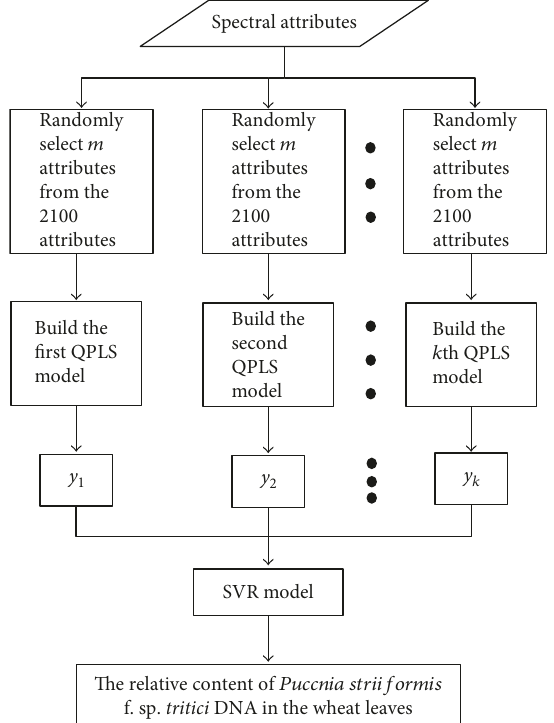
Figure 2: The algorithm fl owchart for building the k QPLS-SVR models to quantify the relative content of Pst DNA in wheat leaves in the incubation